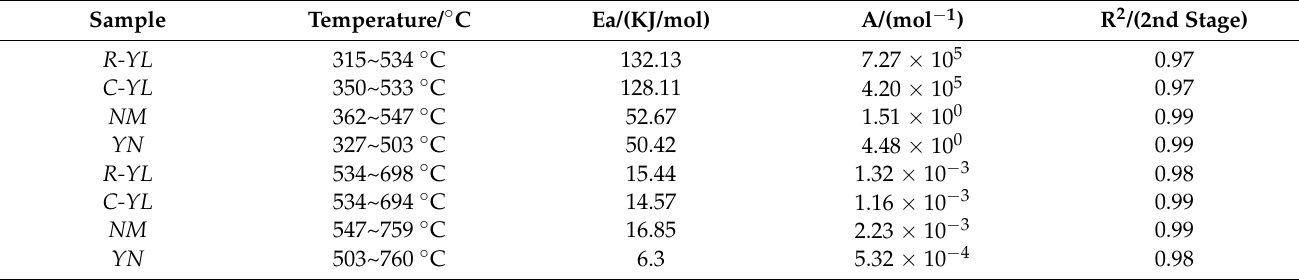
Figure 8. Kinetics obtained by applying Coats–Redfern method for ( a ) NM, ( b ) YN. By linear fitting the plots of diffusion (Zhuravlev equation) model at different temper- ature stages, activation energies E for all four low-rank coals were obtained and are shown in Table 4. Table 4. Kinetic parameters E and A for pyrolysis of four